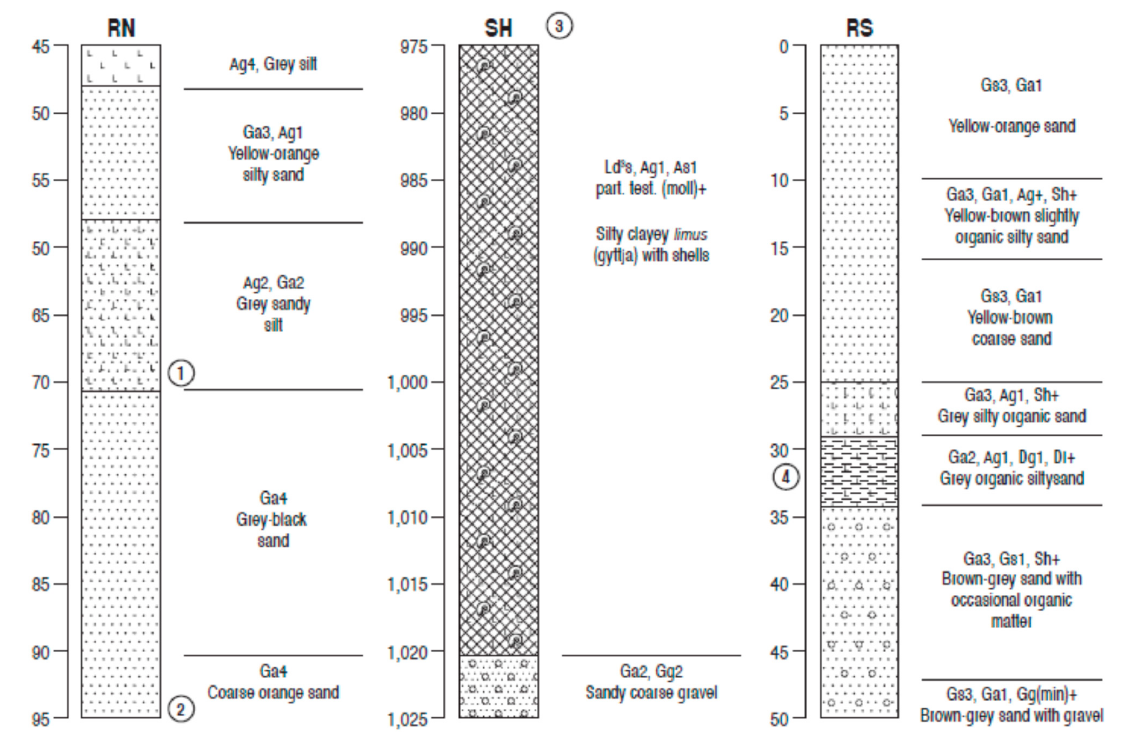
Figure 9. Lithostratigraphy and dating at the Ure sites around Ripon. RN is Ripon North Quarry, SH is the Sharow Mires abandoned channel and RS is Ripon South Quarry (short lower Section 2). Calibrated radiocarbon dates (Table 1) are (1) 2322 ± 165 (2) 3900 ± 50 (3) 4331 ± 95 (4) 4596 ± 185. The Sharow Mires date is higher in the profile because of a lack of suitable terrestrial macrofossil material near the base. Stratigraphic notation and symbols follow Troels-Smith [57], with an English description. Earlier gravel extraction in the Ripon South Quarry, at Ripon Racecourse, exposed very early Holocene channel fill deposits [84].